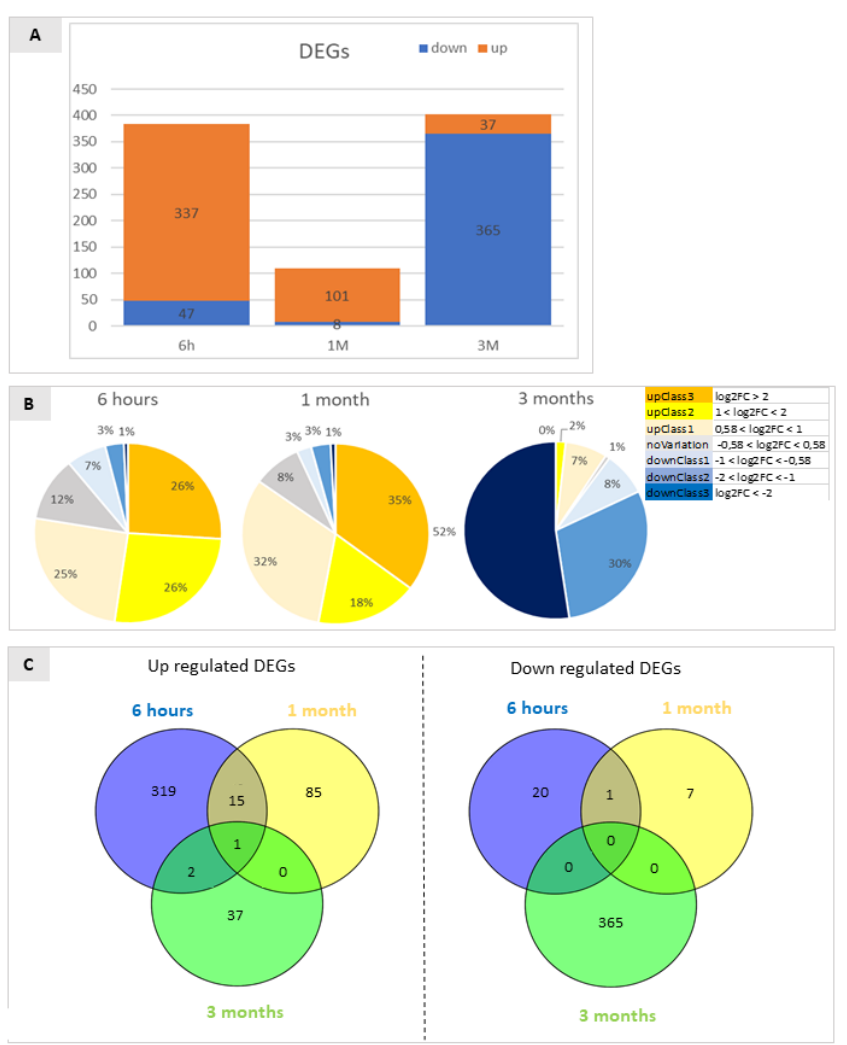
Figure 2. ( A ) Diagram representing the percentage of genes identified as differentially expressed by RNA-Seq analyses in the comparison between wounded and control (unwounded) Granny Smith apple skins at 6 h after wounding (6 h), and after one and three months of storage (1 M and 3 M). Only DEGs with FDR < 5% were included. DEGs were classified as up-regulated or down-regulated (comparison between the treatments is >1 or <1, respectively, accordingly to their FPKM values. The prevalence of mainly up-regulated DEGs in the first two time-points is reversed at the last time point when down-regulated DEGs prevailed. ( B ) Fold change distribution of the DEGs identified by the RNA-Seq experiments in the three comparisons analysed. The ratios reported represent the comparison of wounded vs. control at the three time points of interest. Orange, yellow and pale yellow represent the fraction of genes that are up regulated, the grey area indicates the percentage of genes that show no statistically significant variation, and the blue fractions indicate the percentage of genes that are down regulated in wounded tissue in respect to the control. Different shades indicate the entity of variation based on the log2FC. ( C ) Venn diagrams showing the repartition of down-regulated DEGs and up-regulated DEGs in the comparison between wounded and control samples at three time points. Non-overlapping numbers represent the number of genes unique to each treatment. Overlapping numbers represent the number of mutual genes between treatments. The data refer to samples collected in 2019.